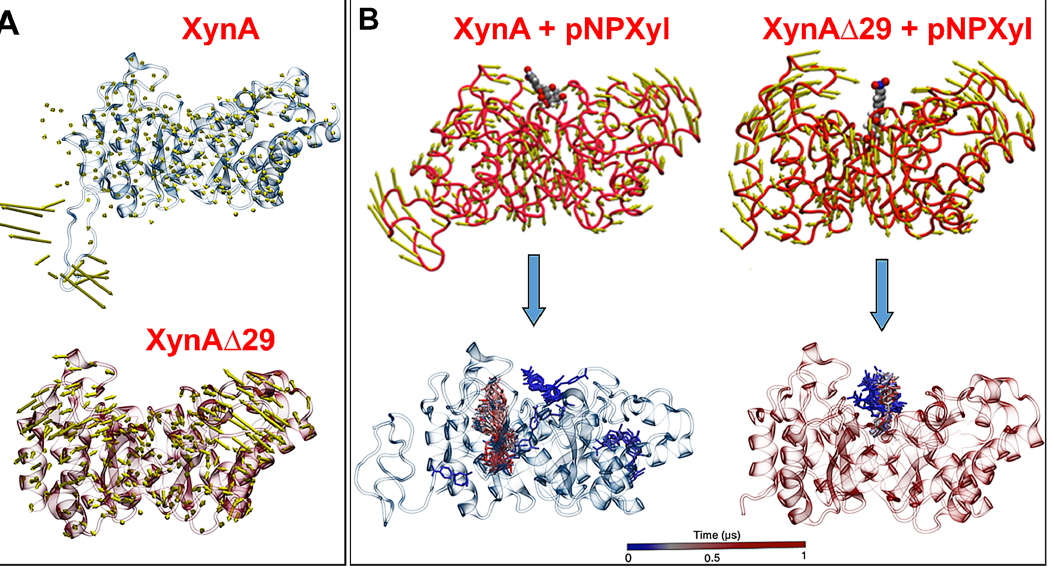
Figure 3. ( A ) Motion of XynA and XynA Δ 29 described by normal mode vectors. The full dynamics can be seen in Supplementary Videos S3 and S4. ( B ) Interactions of pNPXyl with XynA and XynA Δ 29, described by normal modes (upper figures), and tracking of pNPXyl movements in both enzymes during a trajectory of 1 µs (lower figures). Note in the lower figures that pNPXyl always correctly accommodates into the active cleft of XynA Δ 29 while in XynA the substrate shows erratic positioning, mainly around the enzyme. The full dynamics can be seen in Supplementary Videos S5 and S6.